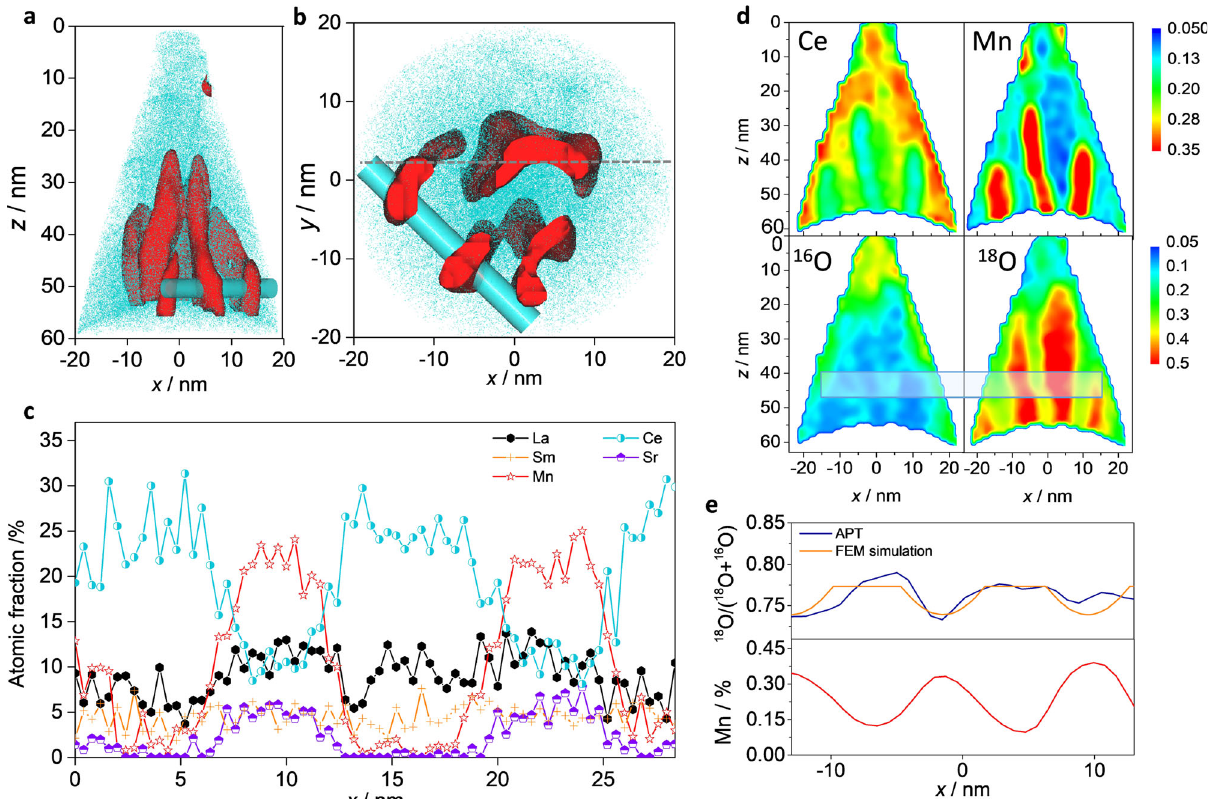
Fig. 2 APT on LSM-SDC. Lateral ( a ) and bottom view ( b ) 3D renderings, highlighting the areas of LSM (red surface) and SDC (light blue dots) using a 30 at% La + Sr + Mn isoconcentration surface. c Cationic atomic fraction along the linescan indicated by the blue cylinder in ( a ) and ( b ). d Concentration color maps for Ce, Mn, 18 O and 16 O from the slice indicated by the gray dotted line in ( b ). e Top: Experimental (blue — obtained upon integration of the area in the rectangle in ( d ) and simulated (red) 18 O fraction pro fi les. Bottom: Mn concentration pro fi le.